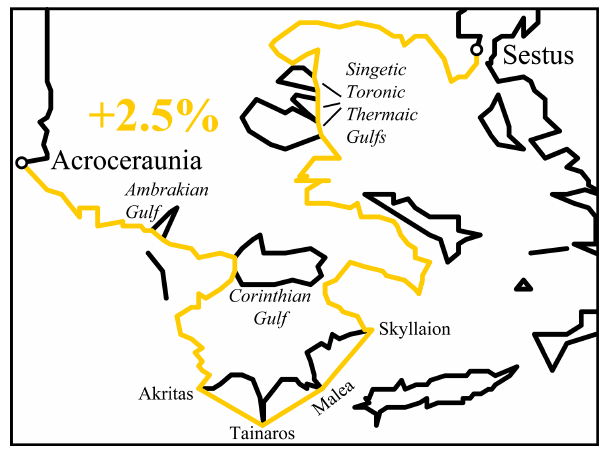
Figure A1. The outlines of Pliny’s “third gulf” of Europe on Ptolemy’s map ( (cid:52) recension) without the “minor gulfs” (shown with